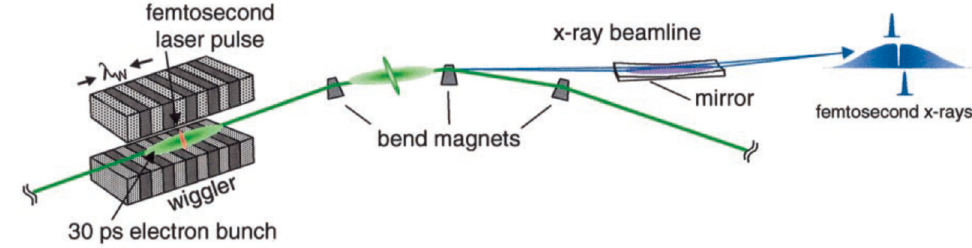
Figure 1. Schematic of the fs-laser slicing method for generating fs-hard X-ray pulses at ALS. Laser interaction with the electron bunch in a resonantly tuned wiggler introduces an energy modulation. The modulated electrons are spatially separated by a dispersive bend. Thus, subsequently produced fs-X-ray pulses will follow a slightly different path and can be selected for probing. Reproduced from Reference [15] with permission from Science AAAS.